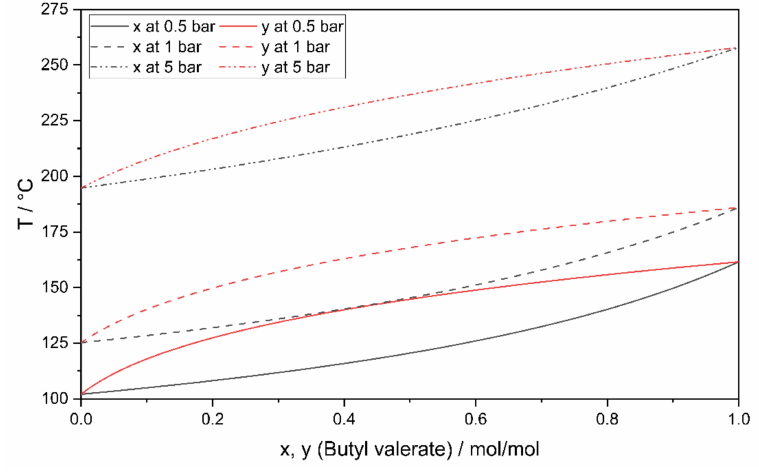
Figure A1. T-x-y-diagram of butyl valerate and n-octane for various